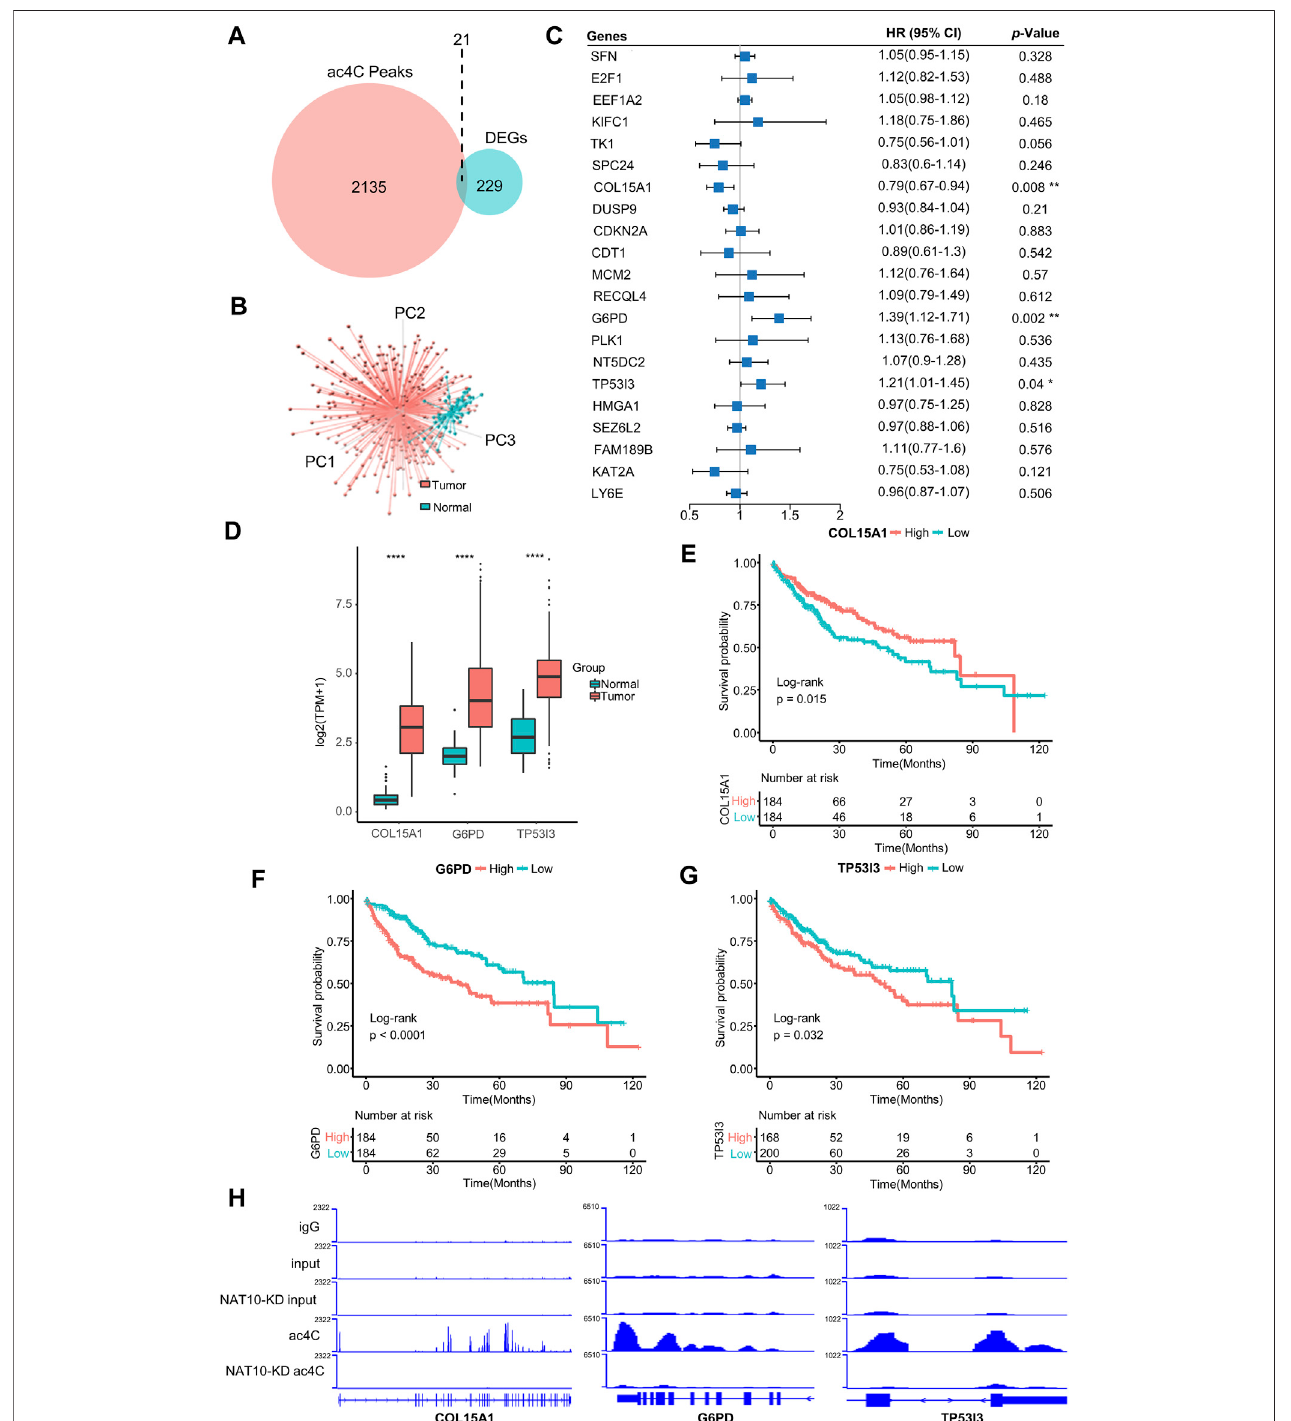
FIGURE 2 | Identi fi cation of ac4C-DEGs associated with prognosis in HCC. (A) Venn diagram shows the number of intersected genes between ac4C peaks and DEGs. (B) Principal component analysis of the expression patterns of 21 ac4C-DEGs distinguishes tumor and normal samples. (C) Forest plot of multivariate Cox analysis determines three key genessigni fi cantly associated with overall survival. HRs are shown with 95% con fi dence intervals. * indicates p < 0.05 and ** p < 0.01. (D) Theexpressionofthreekeygenesbetweennormalandtumorsamples.Thetopandbottomoftheboxesrepresentthe75thand25thpercentiles,respectively.The middle lines in the boxes represent median values. The black dots indicate outliers. **** indicates p < 0.0001. (E – G) Survival analysis for the three key genes. Kaplan- Meiercurveswithlog-rank p values < 0.05areconsideredsigni fi cant. (H) Bargraphsshowdifferentialac4Cmodi fi cationofCOL15A1,G6PD,andTP53I3betweenwild- type and NAT10-ablated